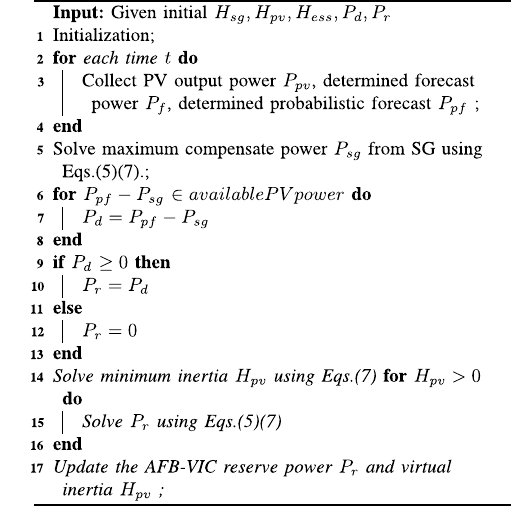
Algorithm2. AFB-VIC − pseudocode.